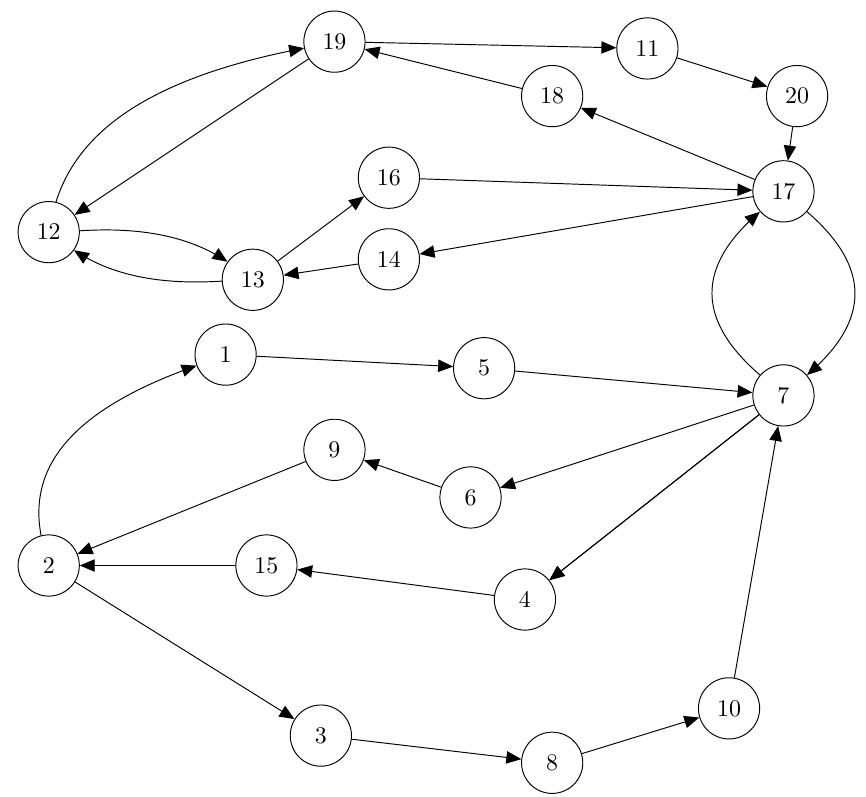
Figure 1: A strongly connected graph G , which contains two 2 -strong blocks C 1 = { 2 , 7 } , C 2 = { 12 , 13 , 17 , 19 } , and one 2 -twinless block B = { 2 , 7 } . Notice that the vertices 12 and 17 do not belong to the same twinless strongly connected component of G \ { 13 }